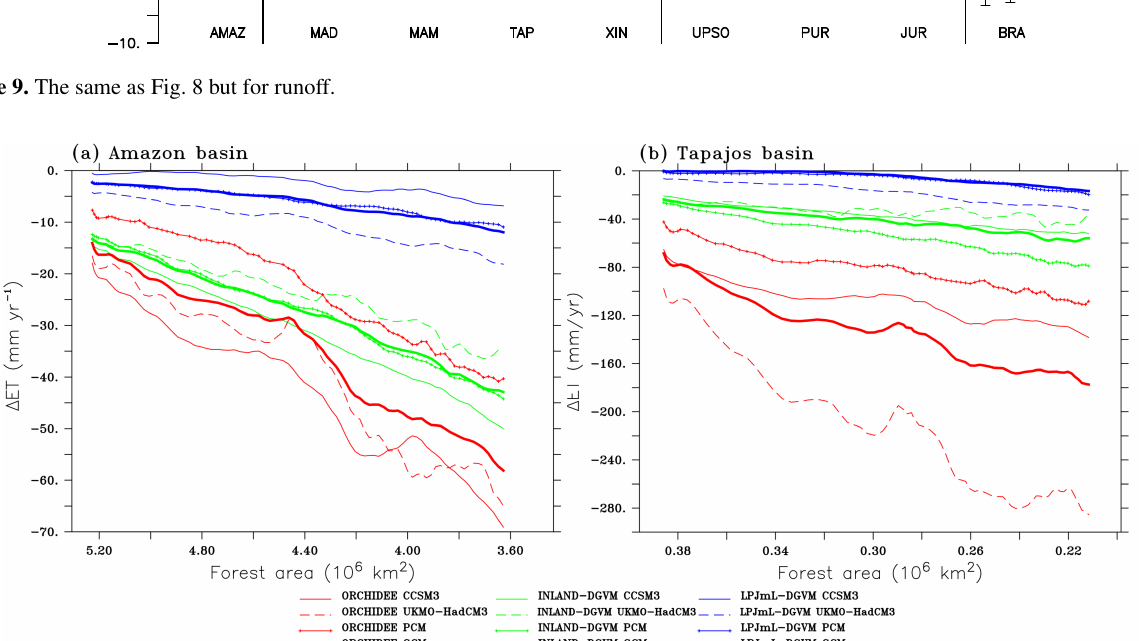
Figure 9. The same as Fig. 8 but for runoff.